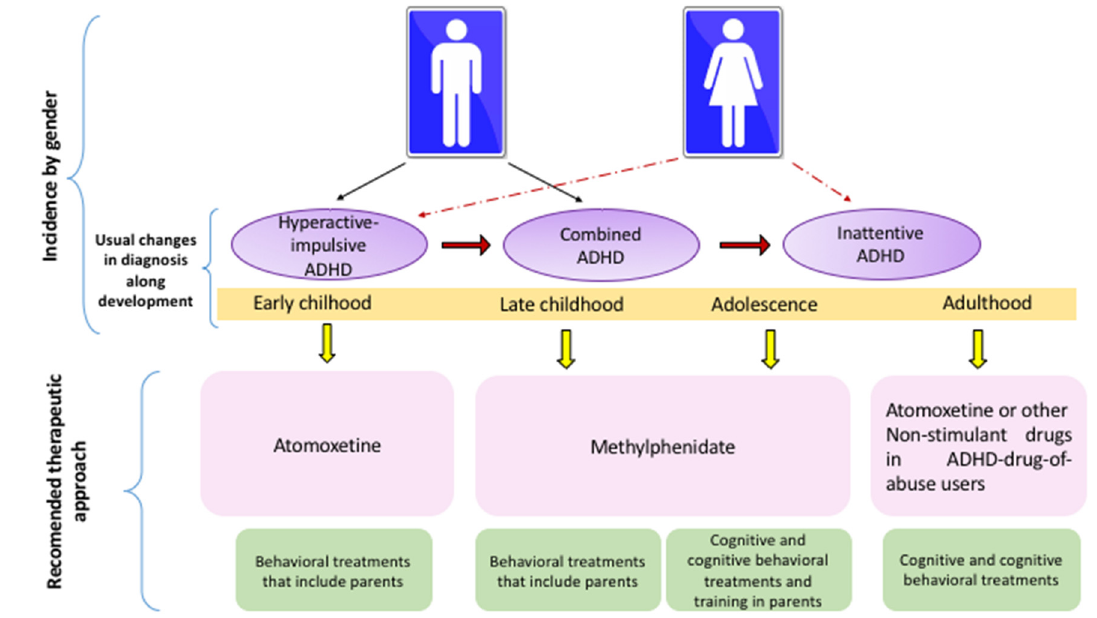
Figure 2. Recommended Behavioral and Pharmacological Approaches for ADHD by Developmental Stage and Clinical Presentation.